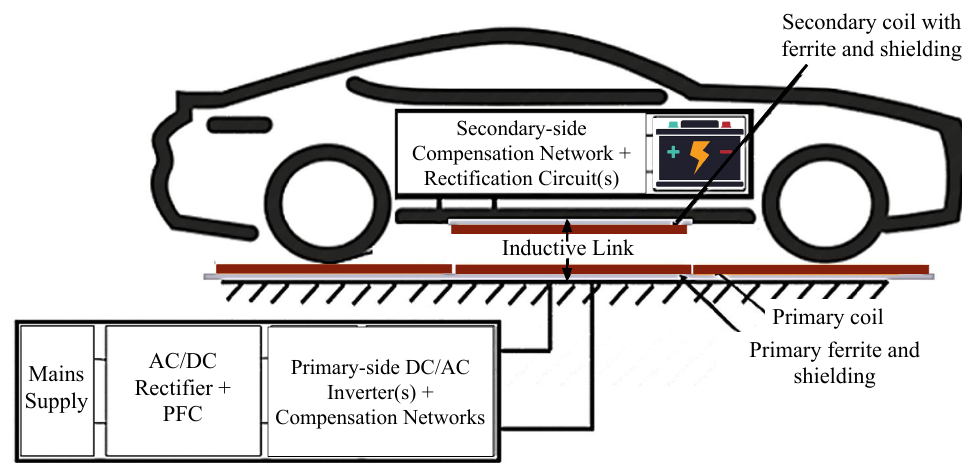
Figure 1. Block diagram of an EV wireless charging